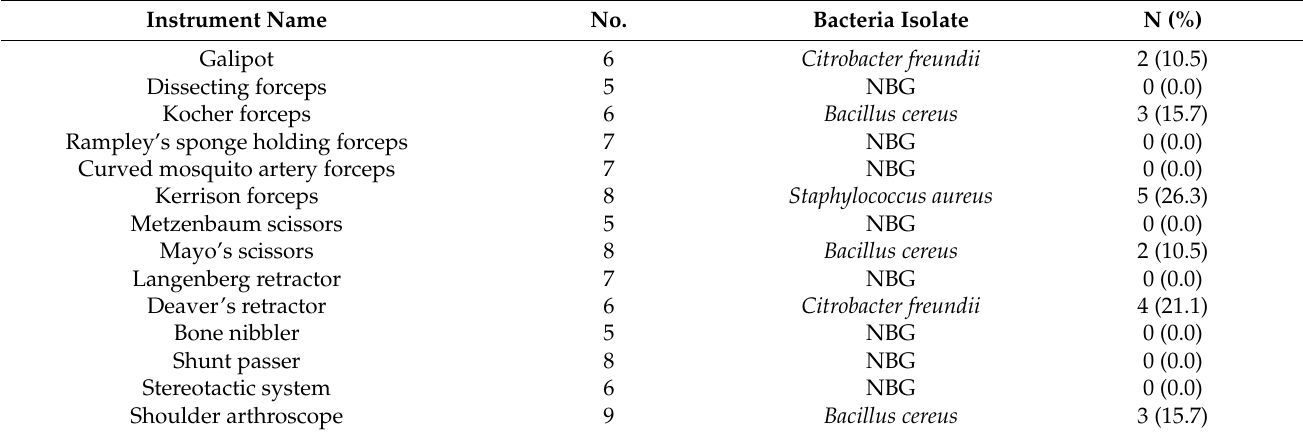
Table 1. Bacterial isolates identified on sterilized surgical instruments from the general surgical theater at the department of